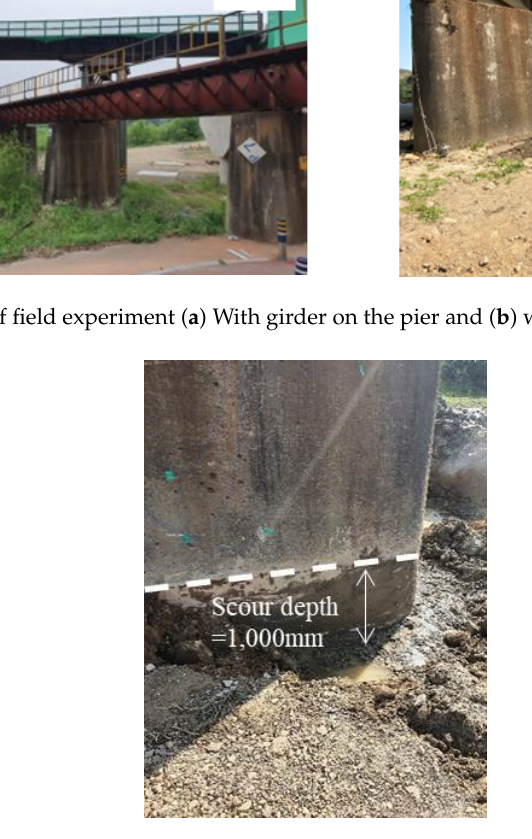
Figure 5. Simulated ground scour (scour depth = 1000 mm).